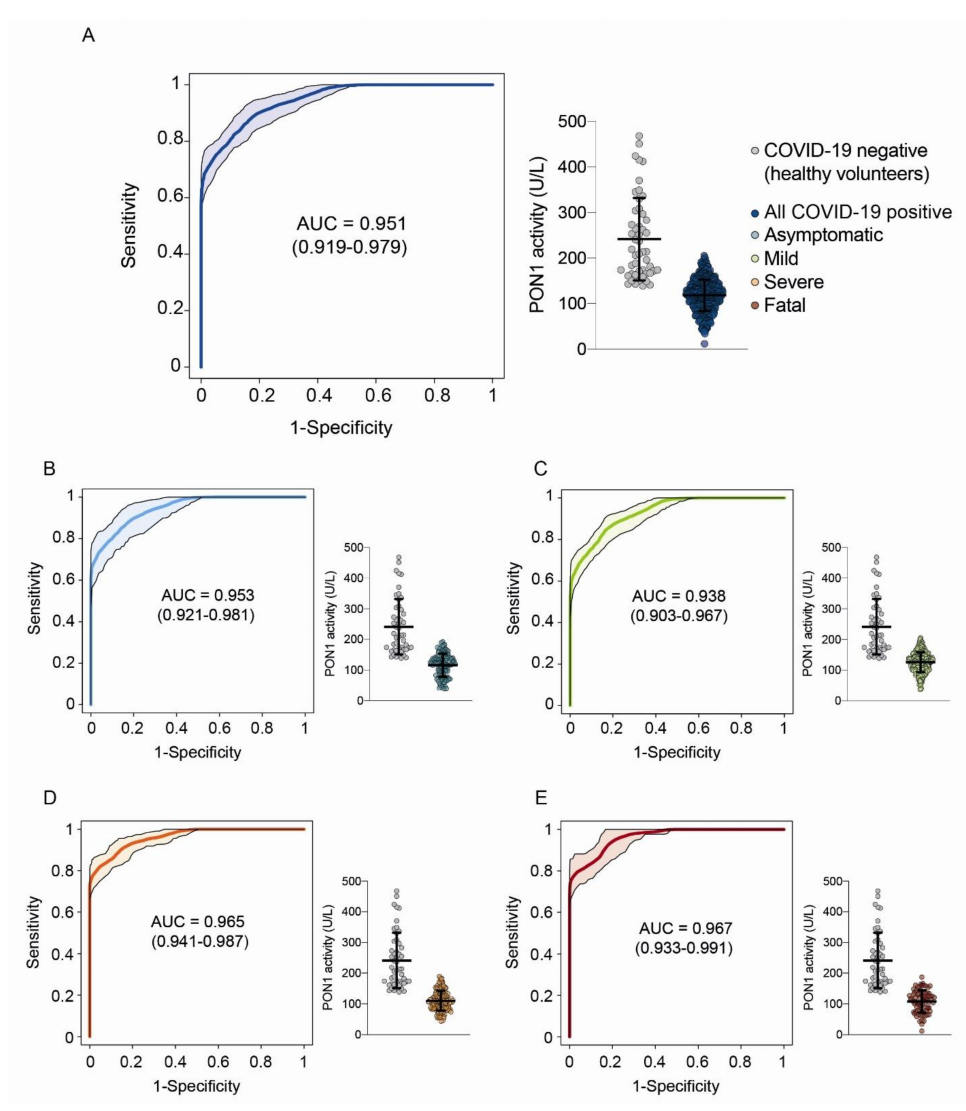
Figure 1. Serum paraoxonase-1 (PON1) activities and Receiver Operating Characteristics (ROC) curves comparing COVID-19-positive patients and the healthy controls; ( A ): All patients combined; ( B ): Asymp- tomatic patients; ( C ): Mild disease; ( D ): Severe disease; ( E ): Fatal disease. AUC: Area under the curve. Table 2. Diagnostic accuracy of paraoxonase-1 (PON1) measurement at two cut-off levels in the differentiation of patients with COVID-19 from non-COVID-19